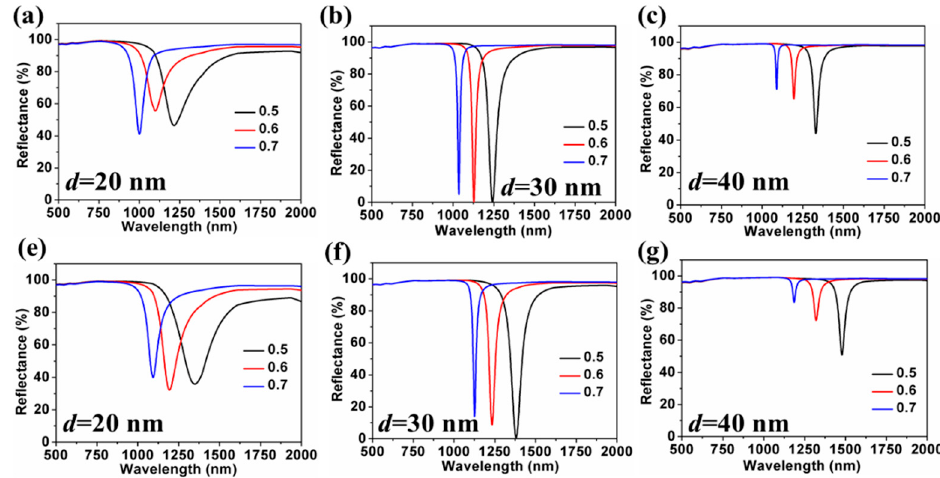
Figure 6. The dependence of the reflectance on d and f for HMM-SPR with SRI = 1.330 ( a , b , c ) and 1.335 ( e , f , g ), respectively.